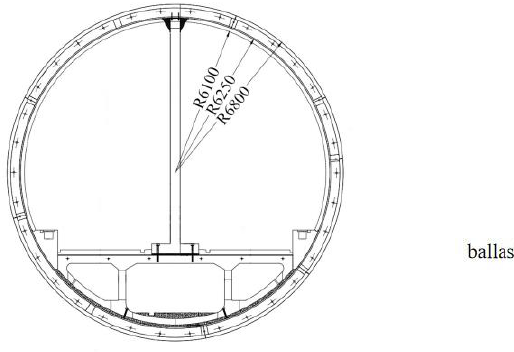
Figure 1. Section structure of double-track tunnel with middle partition wall.